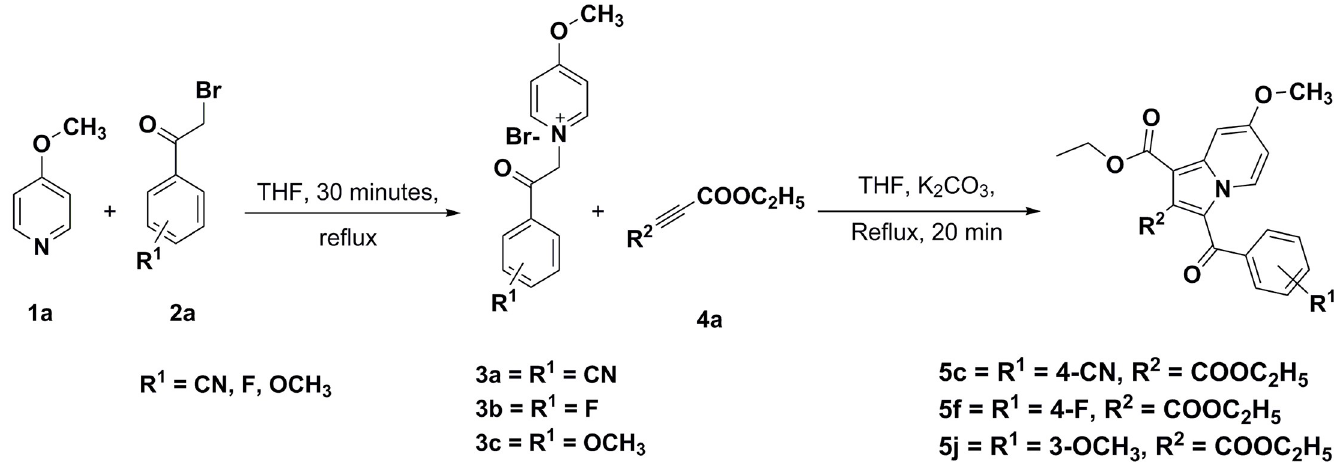
Fig 5. Synthetic scheme for the construction of substituted 7-methoxy-indolizine analogues.